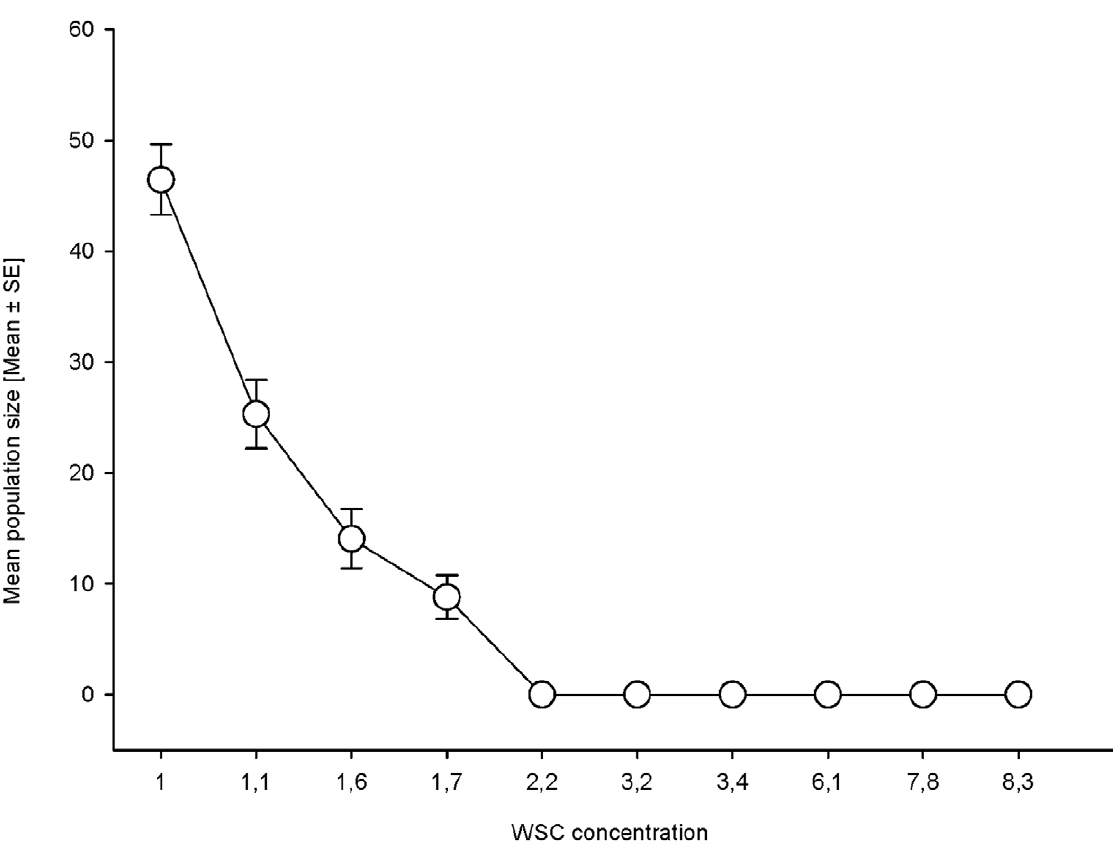
Figure 2. Relationship between mean population size (pooled for the 10 clones tested) and concentration of WSC. Labels on the X axis represent cocksfoot cultivars differing in their WSC content (see Table 2).